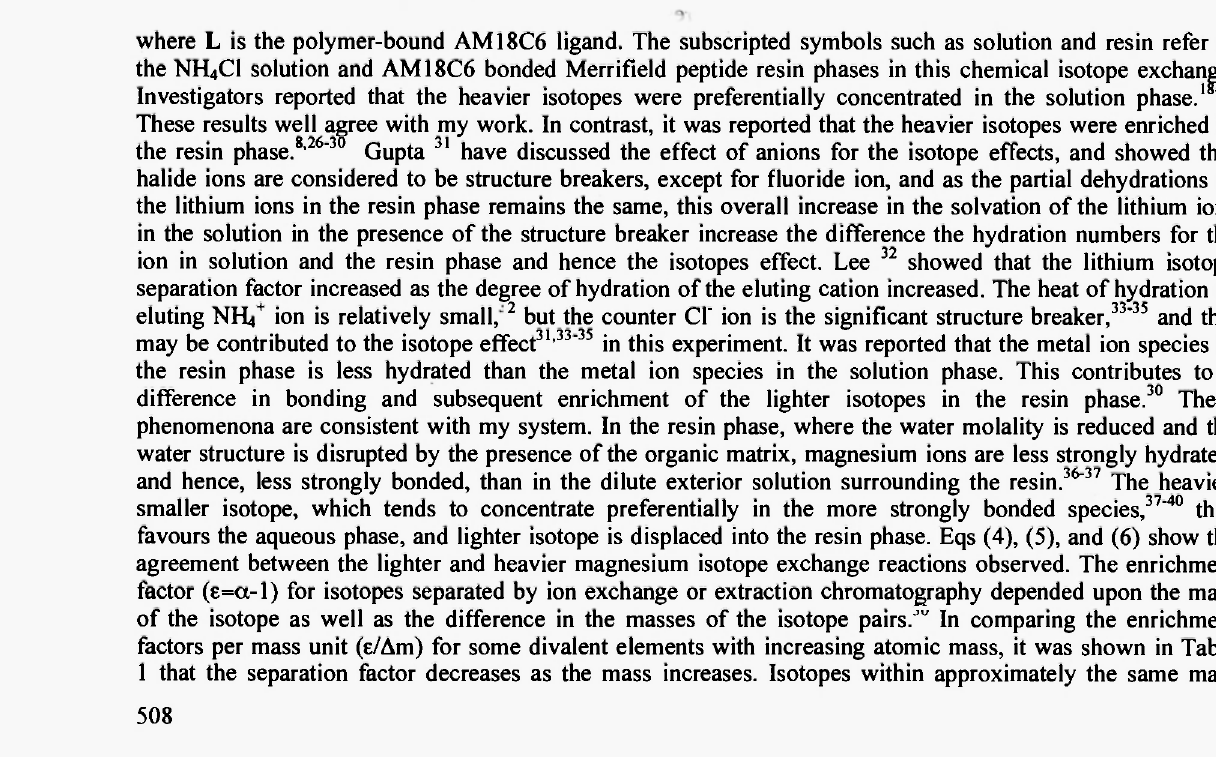
Fig. 2. Enrichment of magnesium isotopes by cation exchange